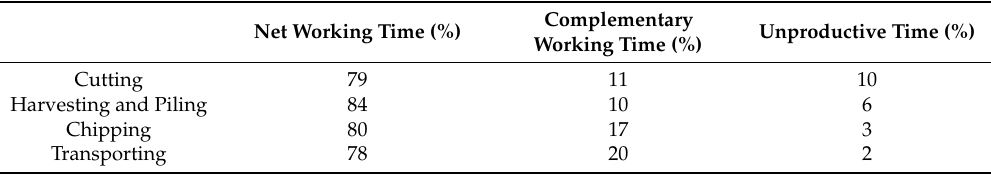
Table 2. Measures of time elements for each working operation.